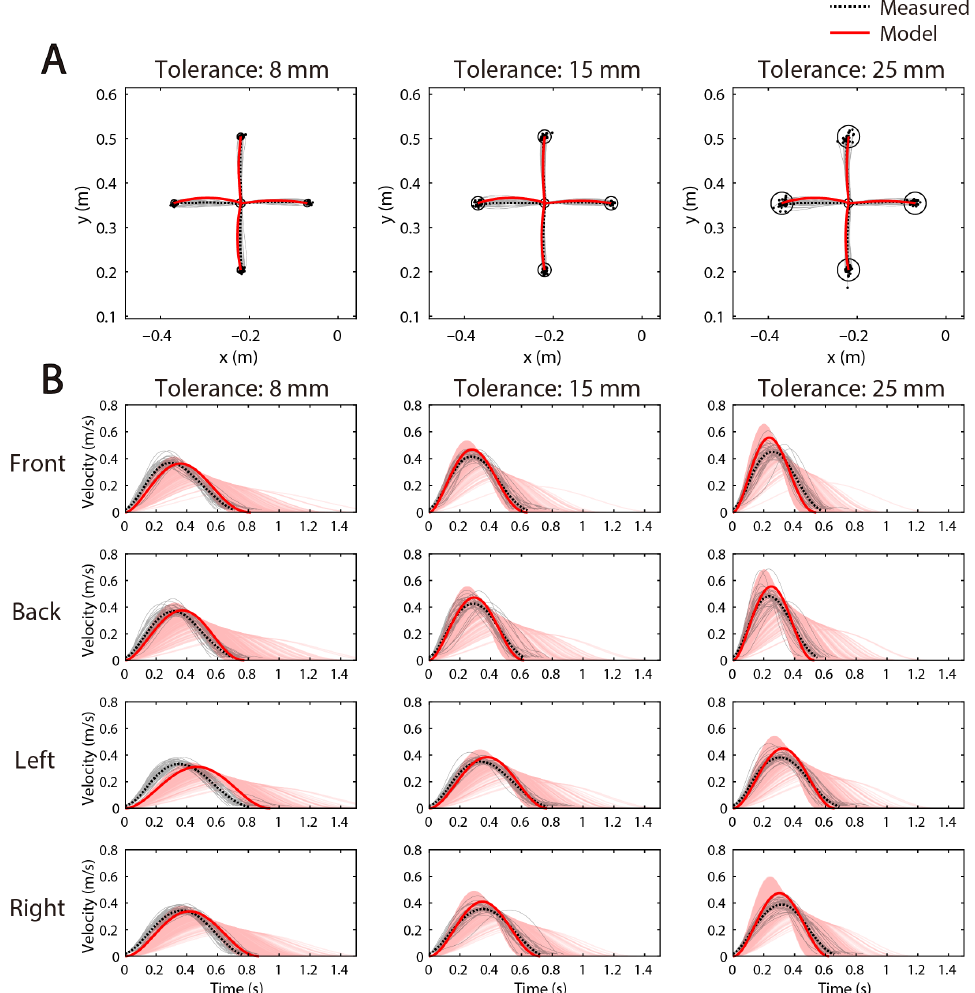
Figure 6. Comparison of the measured and model kinematics of a representative subject (subject A). ( A ) the measured and model hand paths, ( B ) the measured and model tangential velocities. For both ( A , B ), the λ determined for each direction was used. The three axes arranged in a row shows the tolerance: 8.00, 15.0, and 25.0 mm, respectively. The light solid black and dashed black lines represent the measured one for each trial and the average path over all the trials, respectively. The red solid line denotes the average one over all the trials. The light red line obtained by inputting the movement duration determined by the proposed model into the forward inverse relaxation model (FIRM) for each trial; however, this is obscured by the red solid line in ( A ). The black dot represents the endpoint of the hand, and the circle represents the area of